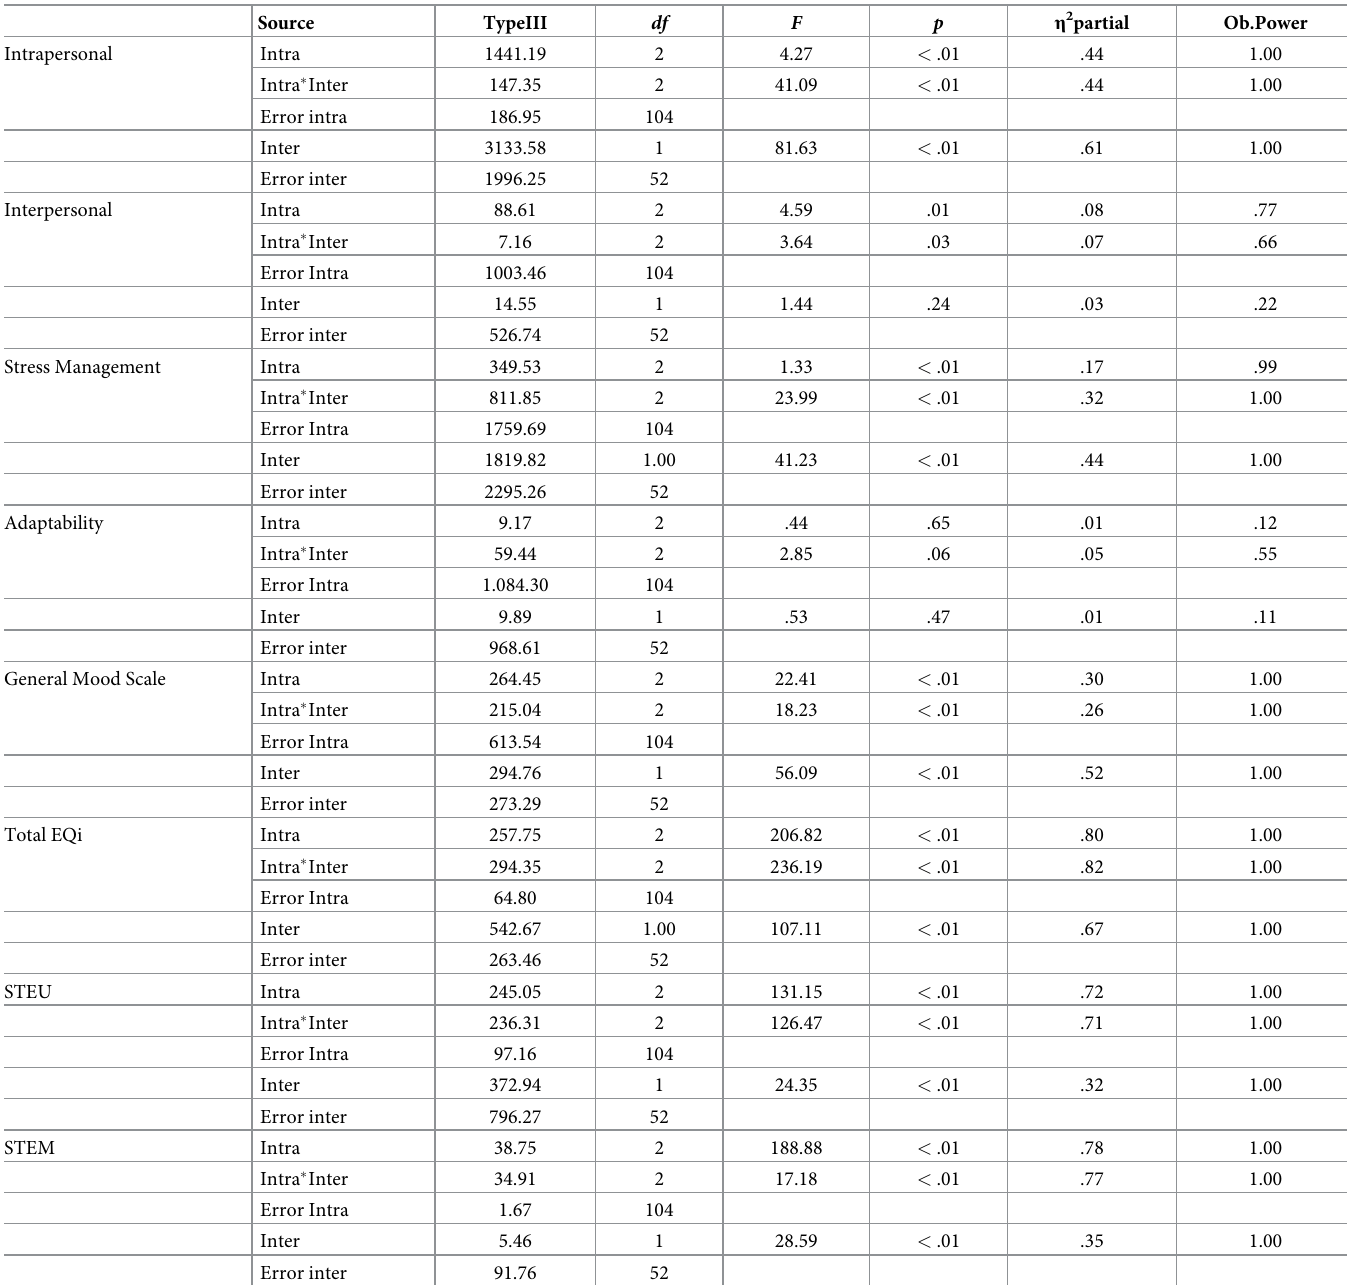
Table 2. Summary of intra- and inter-subject univariate